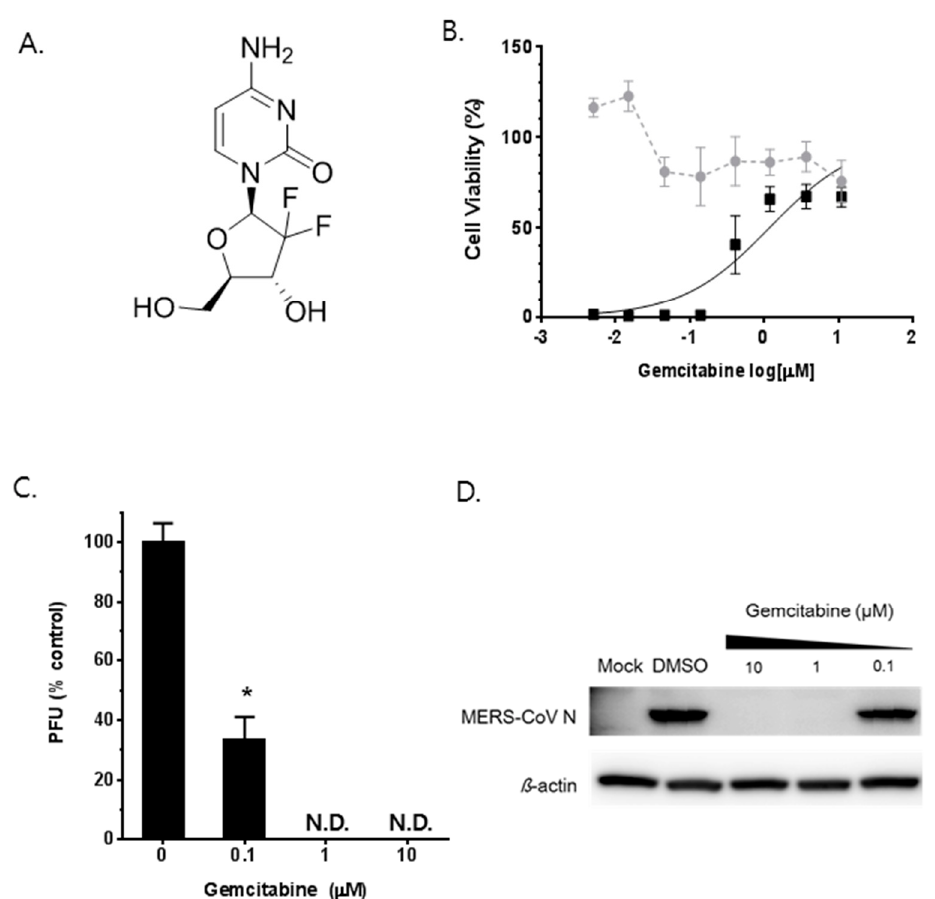
Figure 5. In vitro antiviral activity of gemcitabine against MERS-CoV. ( A ) The structure of gemcitabine. ( B ) Antiviral potency of gemcitabine against MERS-CoV. The antiviral EC 50 (black squares) and CC 50 (grey circles) of gemcitabine were determined by dose-response curve (DRC) analyses as described in Figure 2. ( C , D ) Antiviral efficacy of gemcitabine against MERS-CoV in Huh-7 cells. MERS-CoV infected Huh-7 cells were treated with gemcitabine at indicated concentrations for 24 h, after which the culture supernatant and cell lysates were collected. ( C ) Amount of infectious viral particles released to culture supernatants was determined by plaque assay. ( D ) MERS-CoV N protein levels in lysates of infected cells were determined by Western blot analysis. The immunoblot detection of β -actin is shown as a loading control. Data represent means ( ± SD) of at least two independent experiments performed in duplicate. Significant differences are indicated by * p < 0.05.